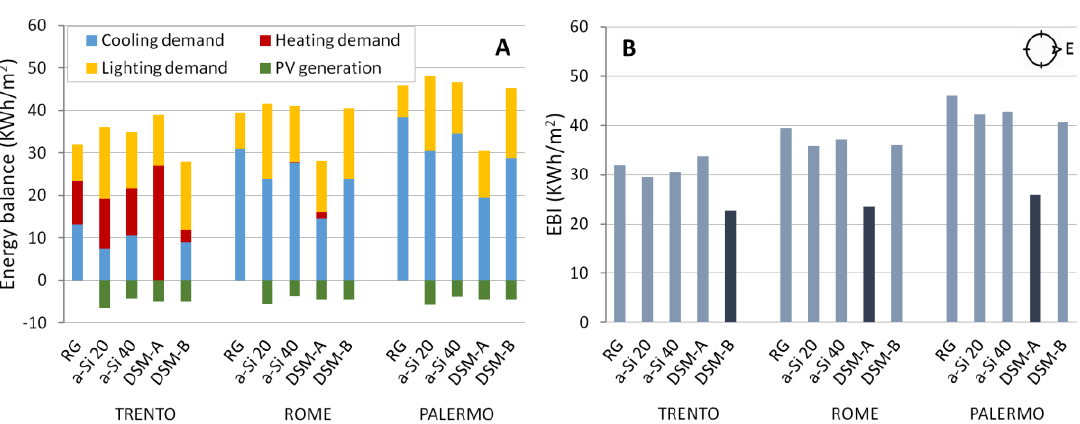
Figure 8. ( A ) Energy balance for the various STPV tested, compared to the reference glass (RG) of the STD building with southern exposure at the three locations; ( B ) EBI index evaluated for the same exposure and glazing elements.